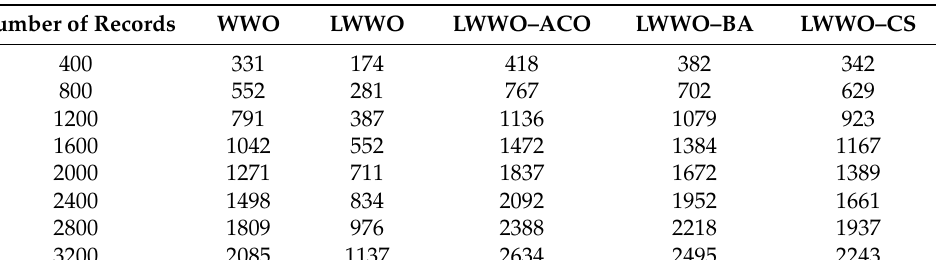
Table 4. Running time of each algorithm with different data volume (ms).